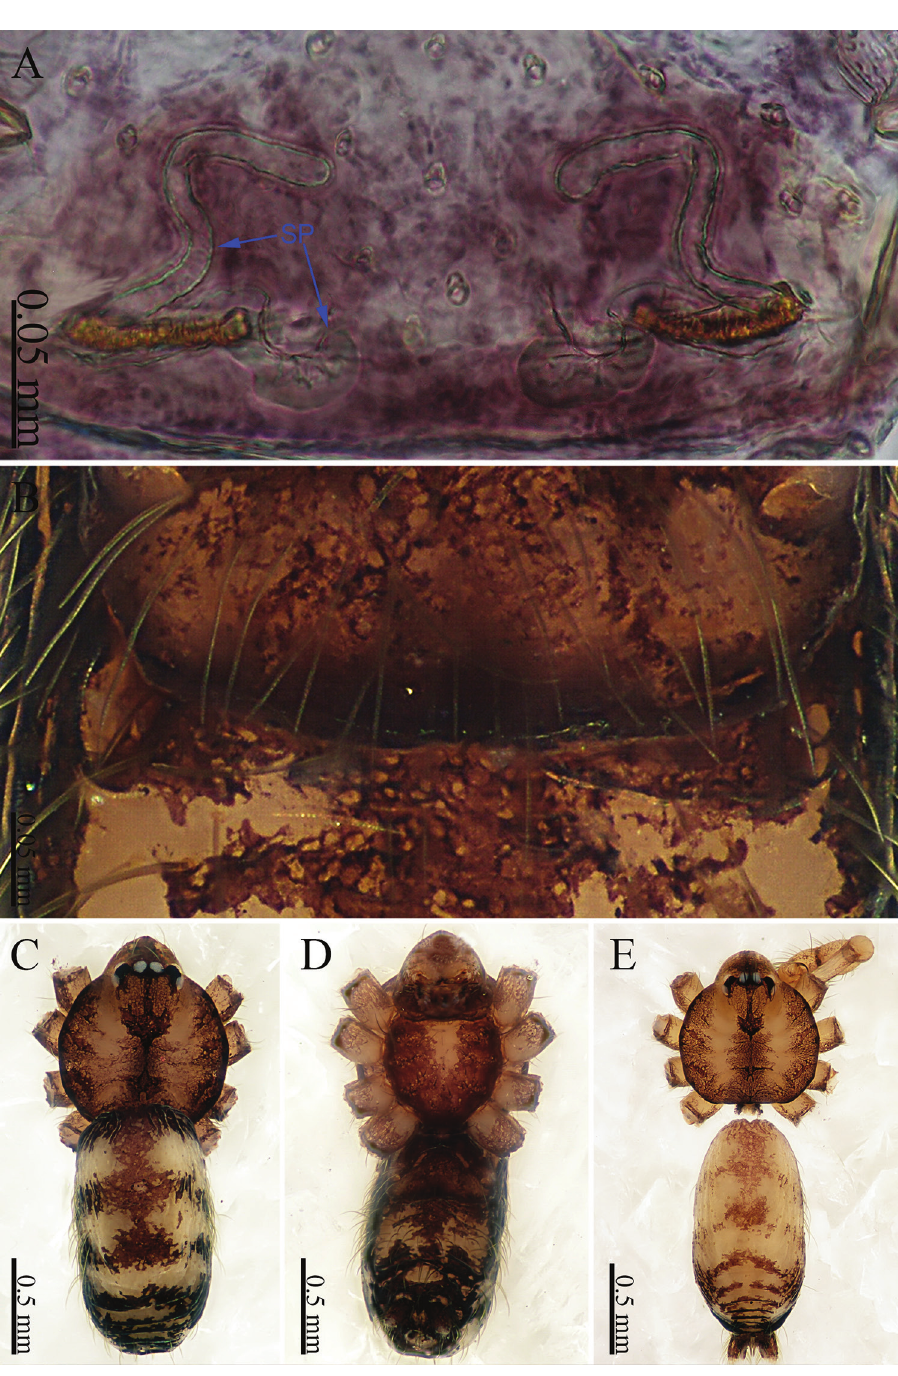
Figure 10. Sinoderces xueae Li & Li, sp. nov., male holotype and female paratype A internal genitalia, dorsal view B female epigastric furrow, ventral view C female habitus, dorsal view D female habitus, ventral view E male habitus, dorsal view. Abbreviation: SP